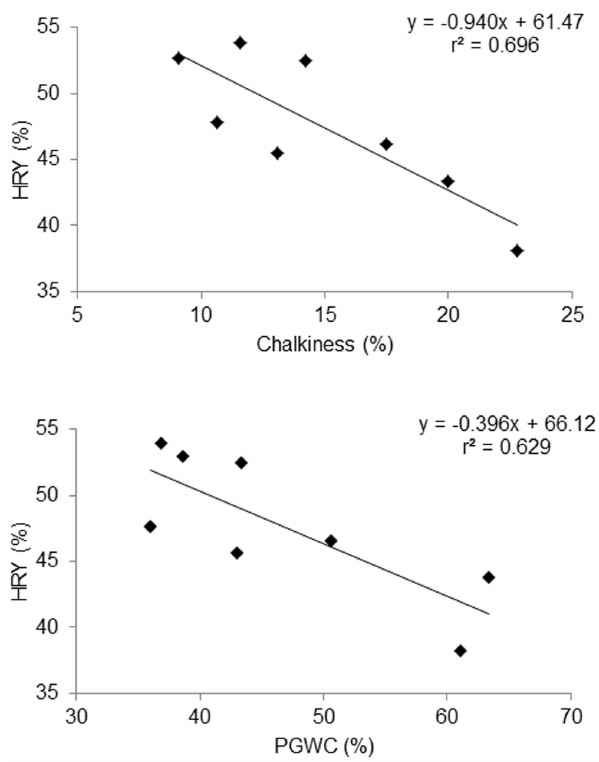
Figure 1. Association between averageof chalkiness, PGWC and HRY of 39 varieties across 8 seasons.